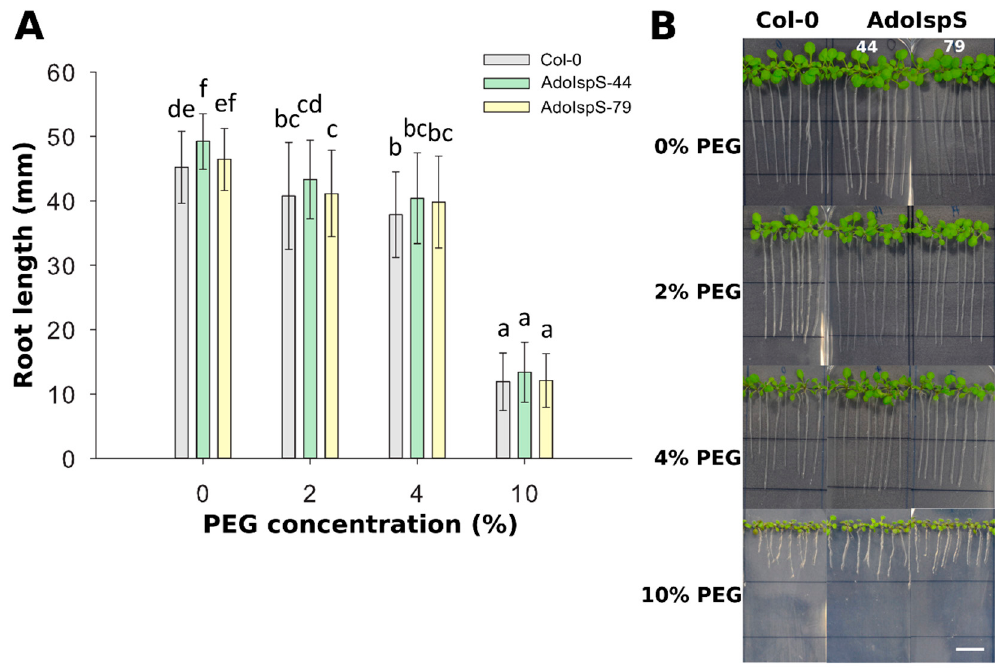
Figure 4. E ff ect of PEG-induced osmotic and water-limitation stress on root elongation. ( A ) Root length of Col-0 and transgenic plants exposed to various concentration of PEG 6000. Histogram bars marked with the same letter do not significantly di ff er from each other (Tukey–Kramer test, p > 0.05). Line bars represent the SD of the means. ( B ) Representative pictures of root growth of Col-0 and transgenic plants exposed to various concentrations of PEG 6000. Scale bar = 1 cm.